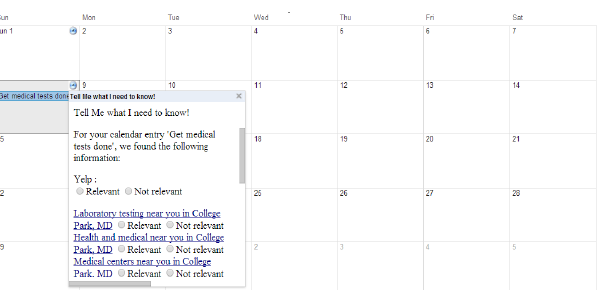
Figure 4: Screenshot of the TellMe client application displaying relevant information for a user’s task